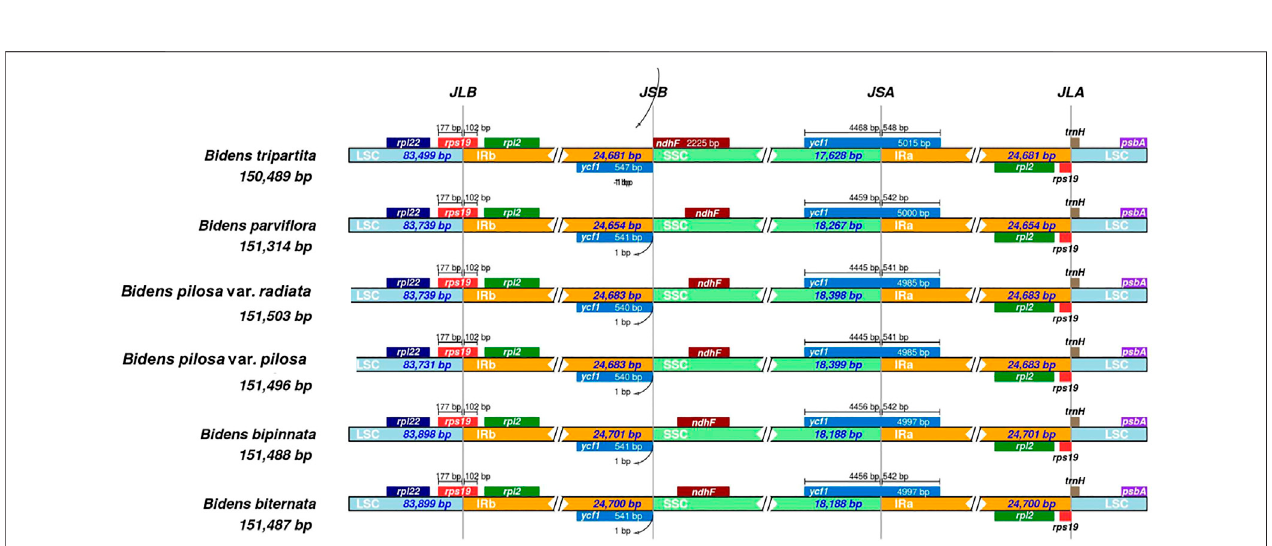
FIGURE 2 | Comparison amongst the borders of LSC, SSC and IR regions in the chloroplast genomes of Bidens species. The number above the gene features indicatesthedistancebetweentheendsofgenesandthebordersites.Thesefeaturesarenottoscale.JLB:junctionofLSC/IRb;JSB:junctionofIRb/SSC;JSA:junction of SSC/IRa; JLA: junction of